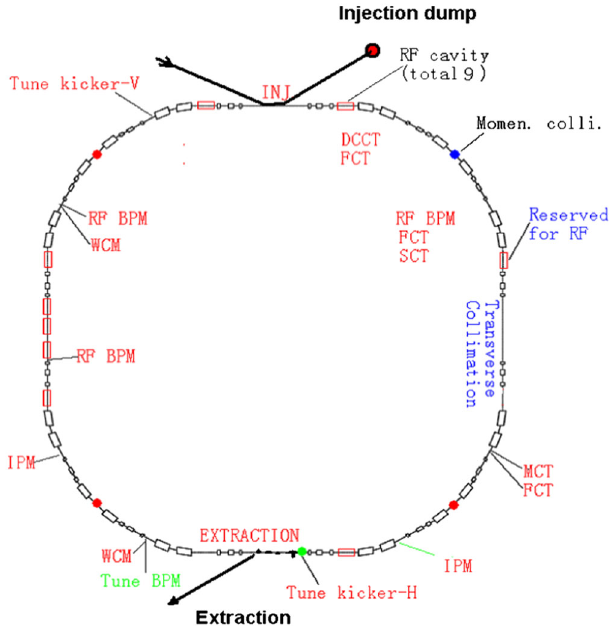
FIG. 1. Layout of the CSNS